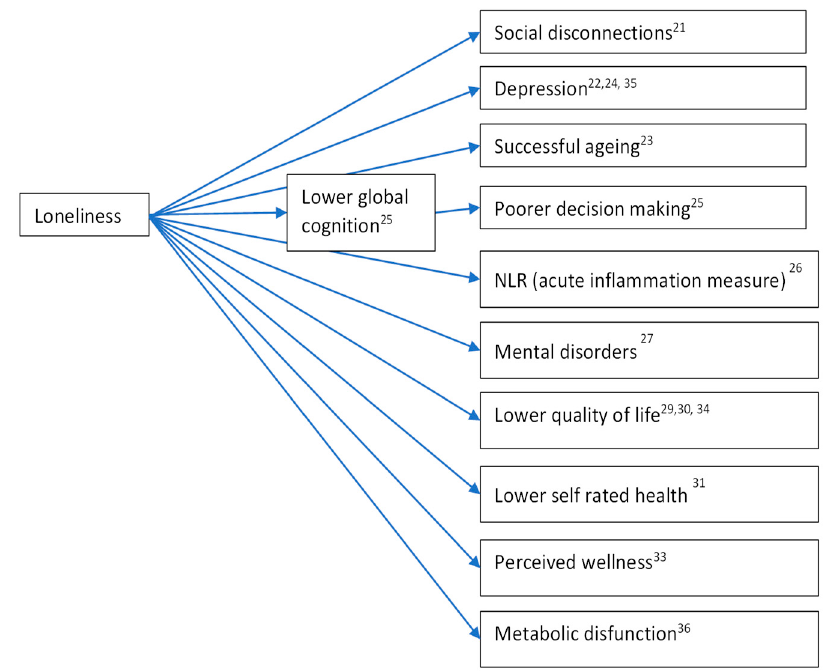
Figure 6. Consequences of loneliness. 21. Talmage et al. (2021); 22. Gonyea et al. (2018); 23. Salamene et al. (2021); 24. Warner et al. (2019); 25. Stewart et al. (2020); 26. Koyama et al. (2021); 27. Gyasi et al. (2019); 29. Ward et al. (2019); 30. Schorr and Khalaila (2018); 31. McHugh and Lawlor (2016); 33. Hodgkin et al. (2018); 34. Tan et al. (2020); 35. McHugh Power et al. (2020); 36. Shiovitz-Ezra and Parag (2019).